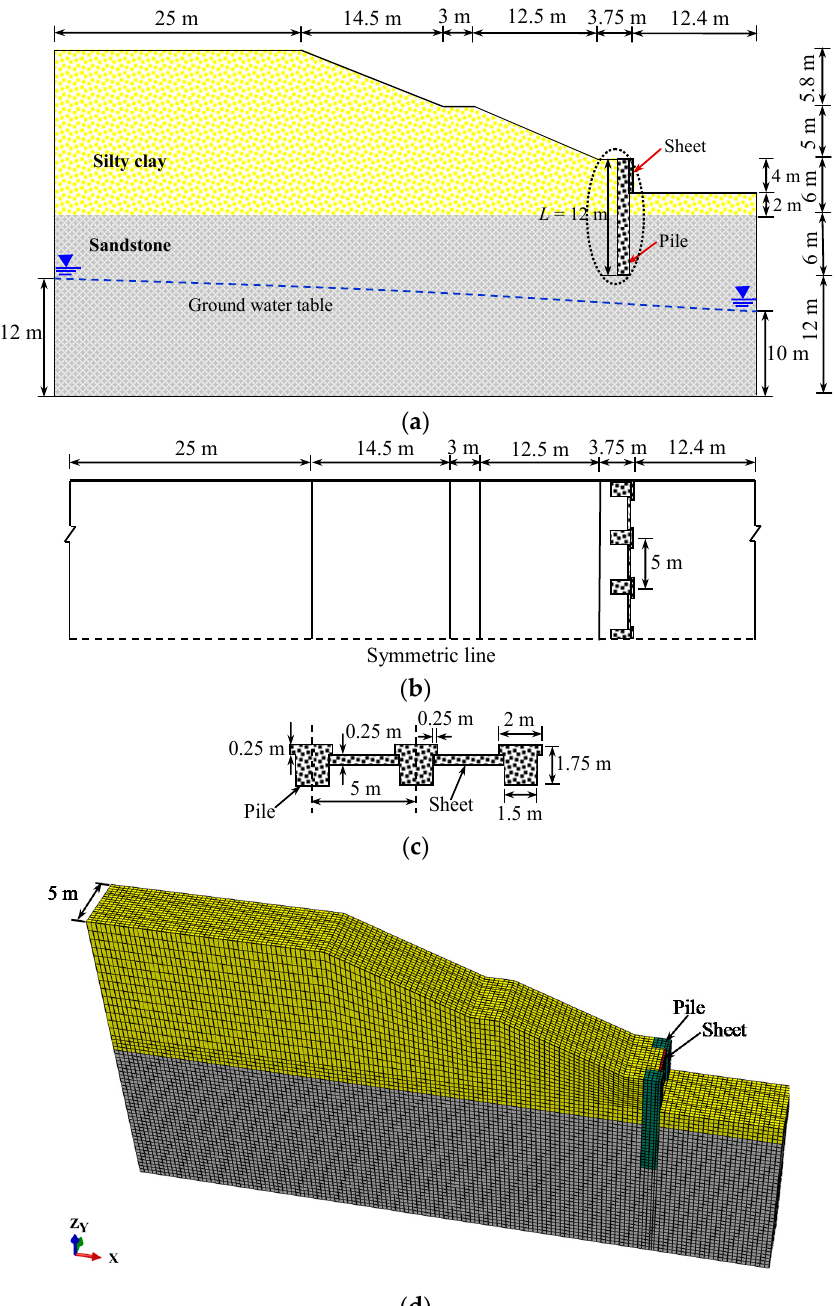
Figure 2. Slope-sheet pile wall system at Jilin–Tumen–Hunchun high-speed railway. ( a ) Cross-section of soil slope-sheet pile wall system; ( b ) Vertical view of soil slope-sheet pile wall system; ( c ) Detail dimensions of pile and sheet; ( d ) Finite element